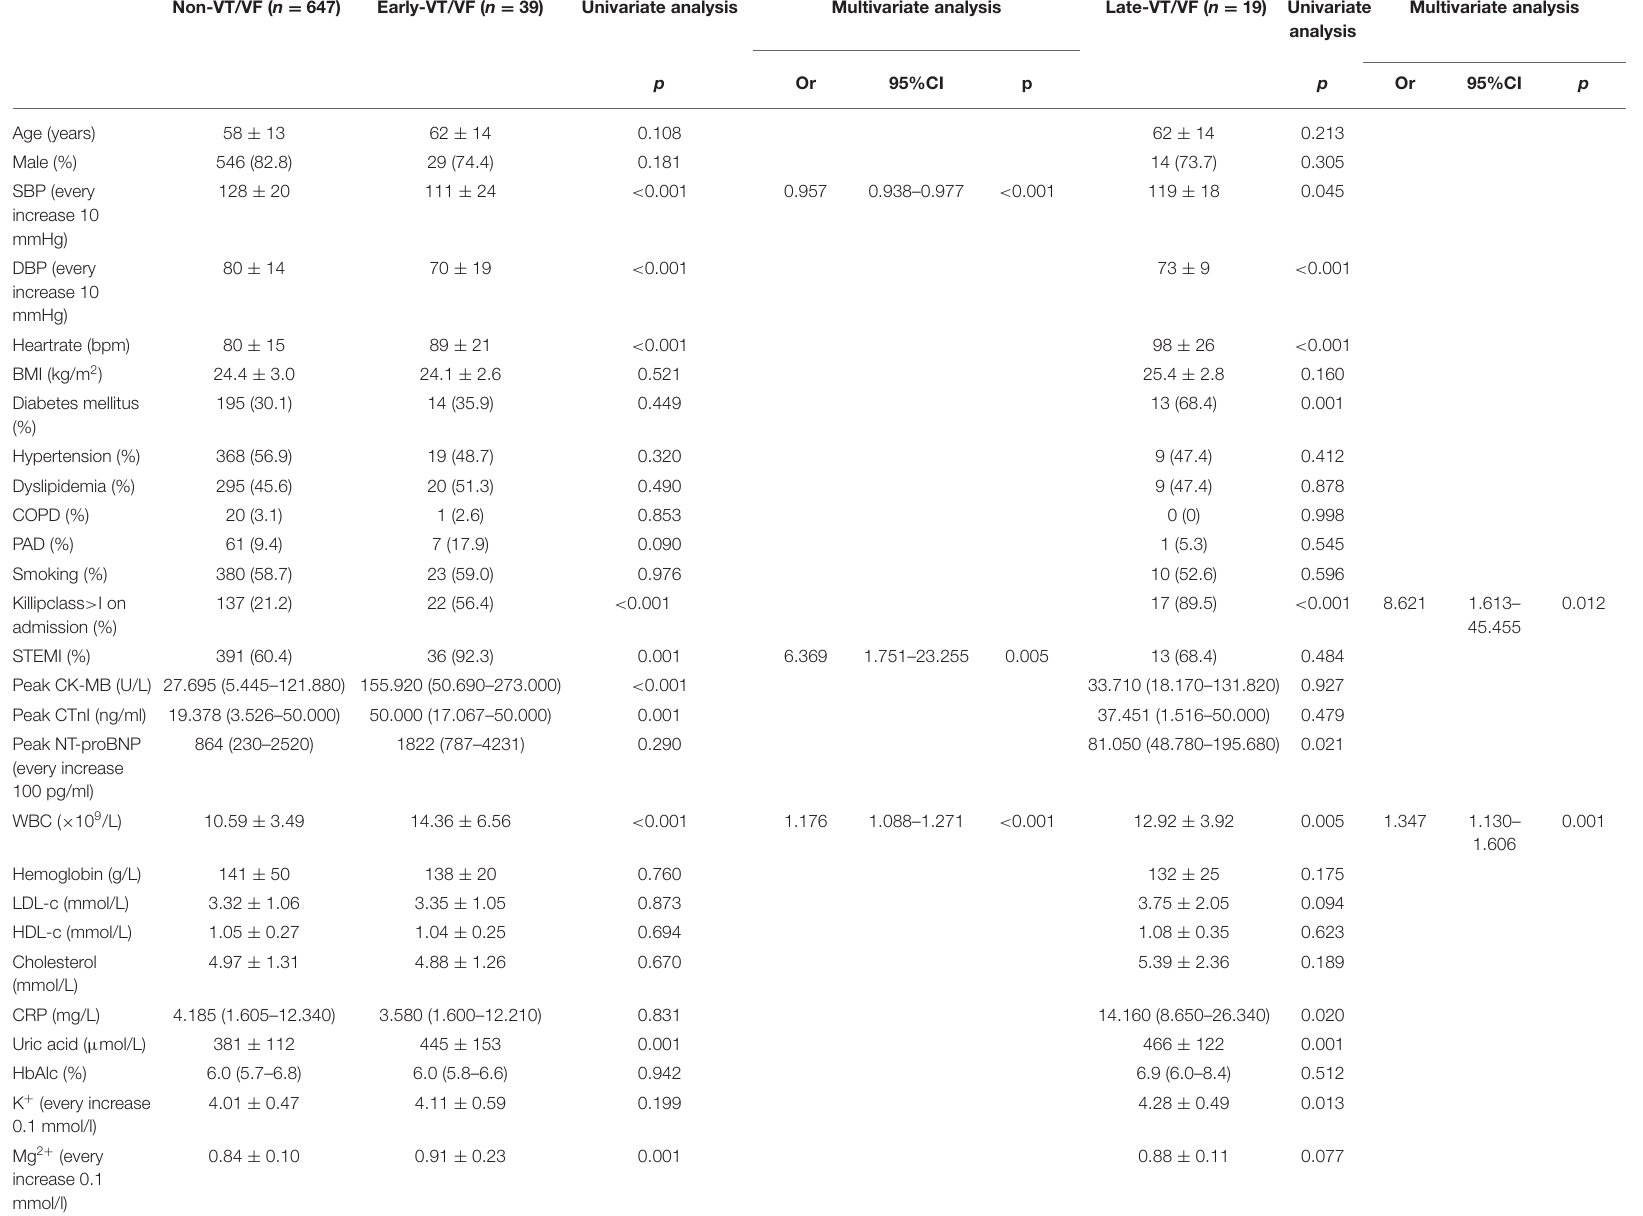
TABLE 5 | Characteristics of patients with early-VT/VF or late-VT/VF: univariate and multivariate analyses of the predictors in both groups. Non-VT/VF ( n = 647) Early-VT/VF ( n = 39) Univariate analysis Multivariate analysis Late-VT/VF ( n = 19) Univariate